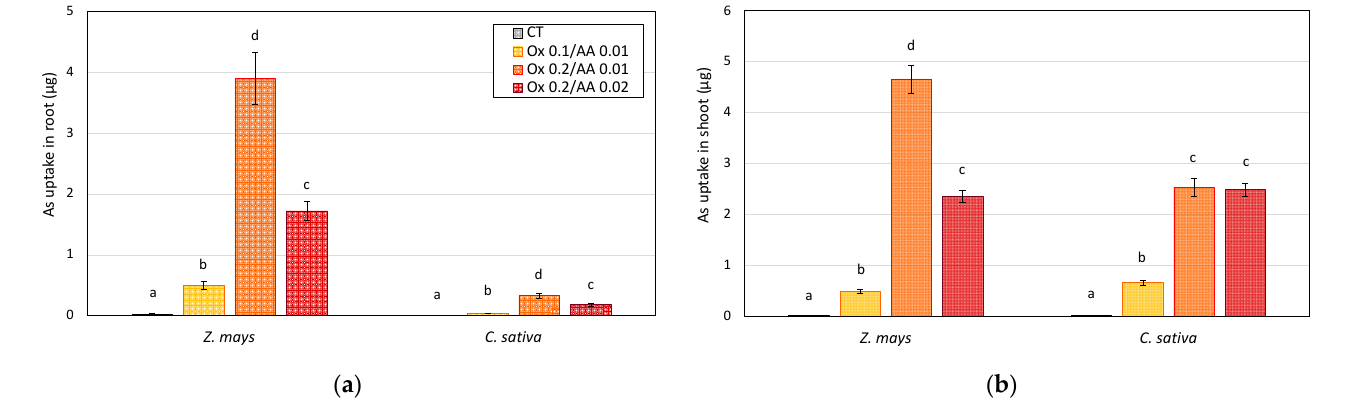
Figure 4. Arsenic uptake by ( a ) roots and ( b ) shoots of Z. mays and C. sativa grown on As-contaminated soils treated with different mixtures of oxalate and ascorbic acid (microcosm tests). The values are the means of three replicates and the error bars show the standard deviations. Values with different letters are significantly different at the 5% probability level (Tukey’s test).